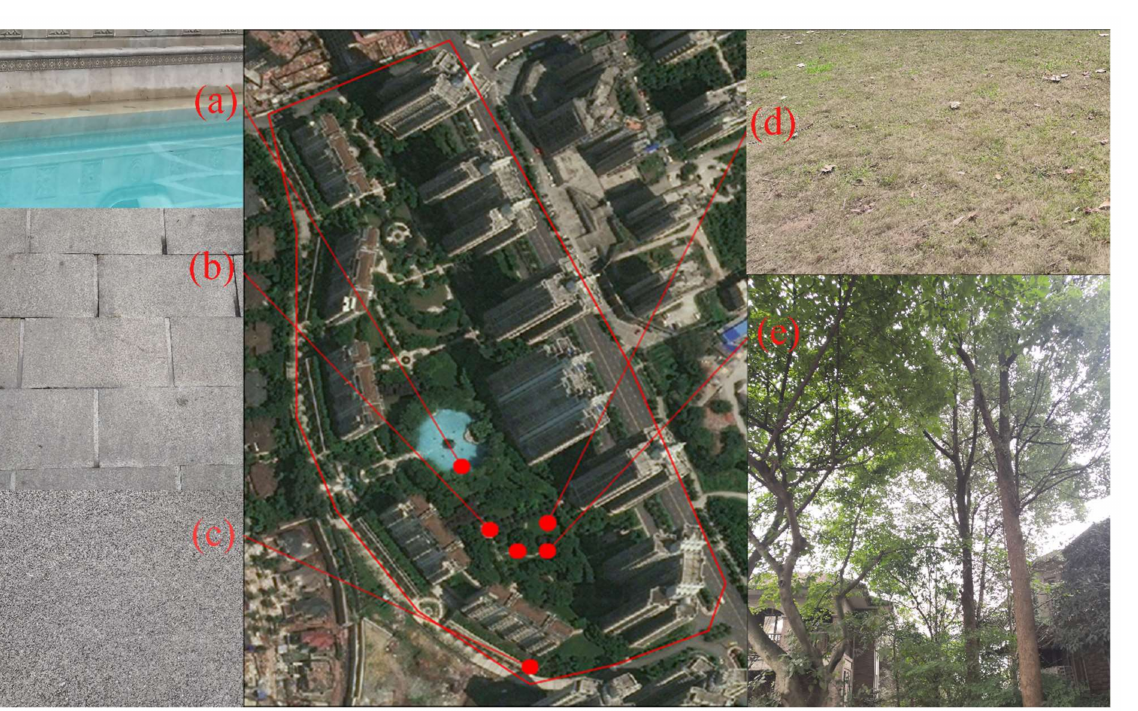
Figure 1. Residential community with five common underlying surfaces: ( a ) pond, ( b ) masonry, ( c ) asphalt, ( d ) lawn, and ( e )